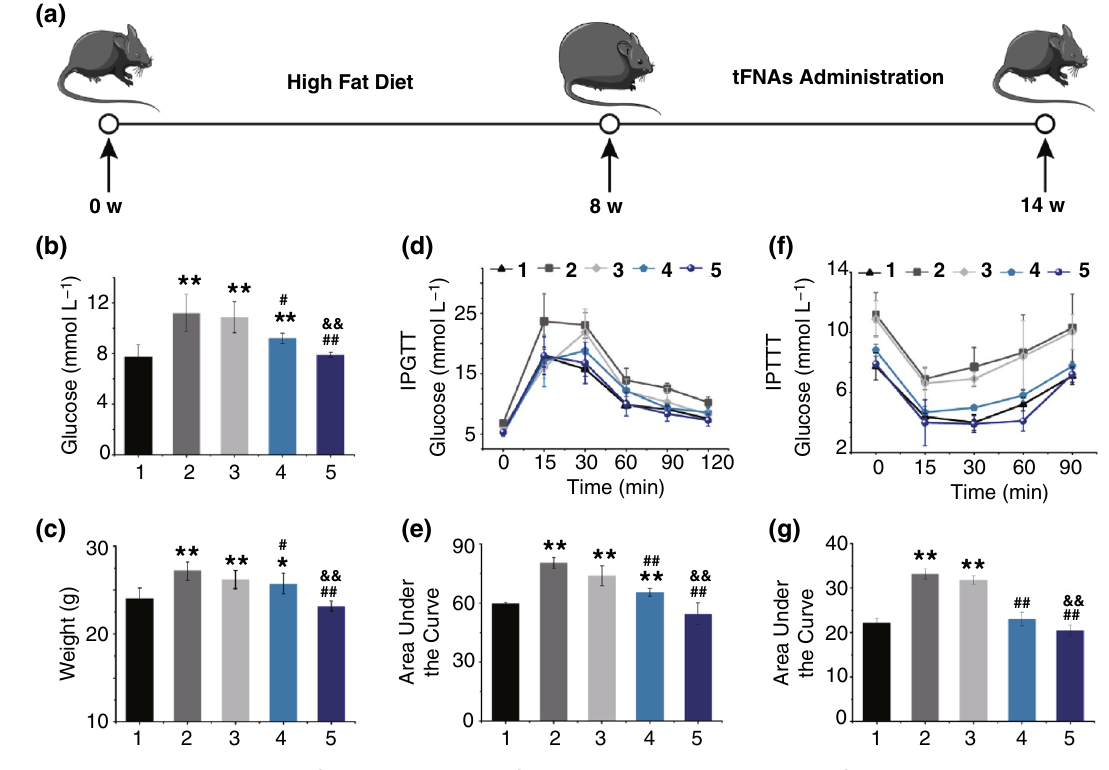
Fig. 2 tFNAs-RSV improved glucose homeostasis and insulin sensitivity. a Scheme of the treatments of obesity-induced insulin resistance using HFD feeding mice as models and C57BL/6 J mice as the controls. b Glucose concentration of normal mice and HFD feeding mice with or with- out drug administration; c body weights of normal mice and HFD feeding mice with or without drug administration; d IPGTT result of normal mice or HFD feeding mice with or without drug administration; e area under the curve of IPGTT; f IPITT result in normal mice or HFD feed- ing mice with or without drug administration; g The area under the curve of IPITT. Data were performed using one-way analysis of variance (ANOVA) and presented as mean ± SD ( n ≥ 3). Statistical analysis: *Compare with the control group, * P < 0.05, ** P < 0.01; # Compare with the LPS and IFN-γ group, # P < 0.05, ## P < 0.01; & Compare with the control group, & P < 0.05, && P <